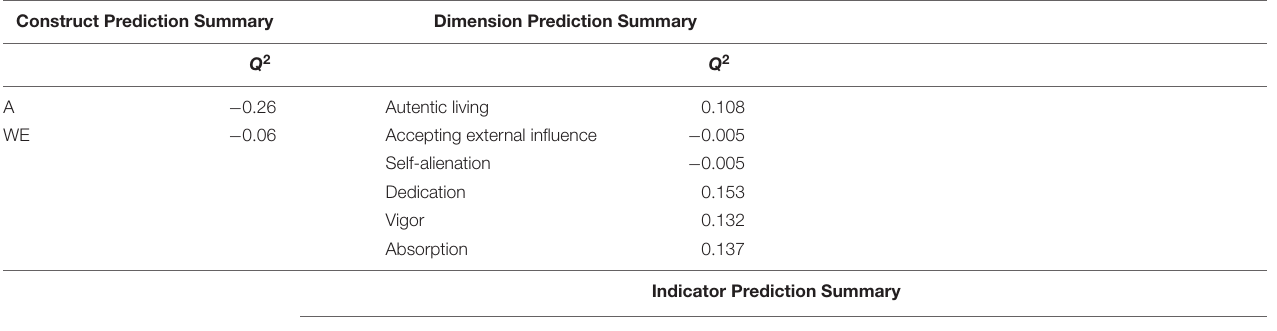
TABLE 6 | Partial least squares prediction